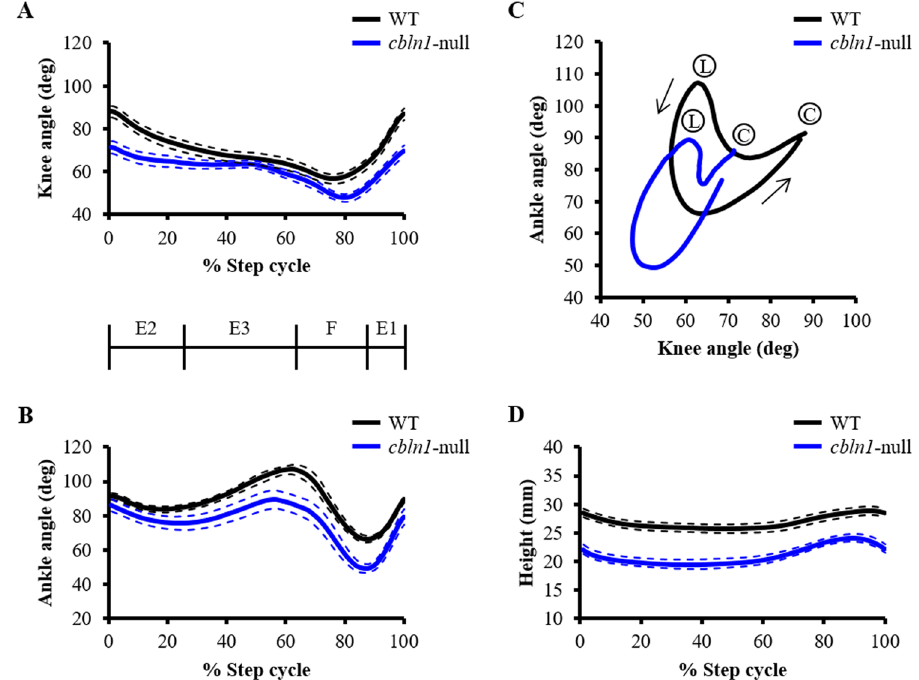
Figure 3. Kinematics of displacement during the step cycle. ( A,B ) Average angular displacements during the step cycles of wild-type (WT, black line) and cbln1 -null (blue line) mice. Dotted lines indicate SEM. ( C ) Mean interjoint coordination patterns during the step cycle. Each line illustrates the averaged data for interjoint coordination patterns of the ankle and knee joints in wild-type (WT, black line) and cbln1 -null mice (blue line). C: Foot contact at the beginning of the stance phase; L: foot lift at the beginning of the swing phase. Arrows indicate the direction of angular motions. ( D ) Average great trochanter height displacements during the step cycle in wild-type (black line) and cbln1 -null (blue line) mice. Dotted lines indicate